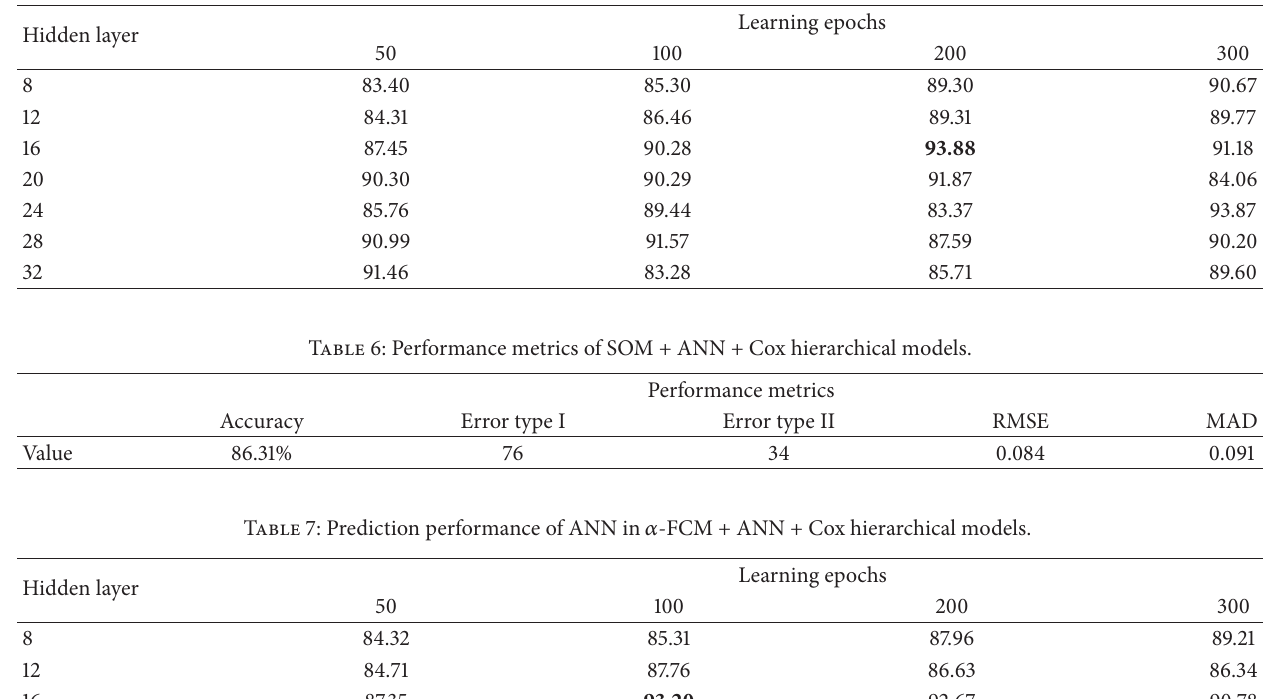
Table 5: Prediction performance of ANN in SOM + ANN + Cox hierarchical models.